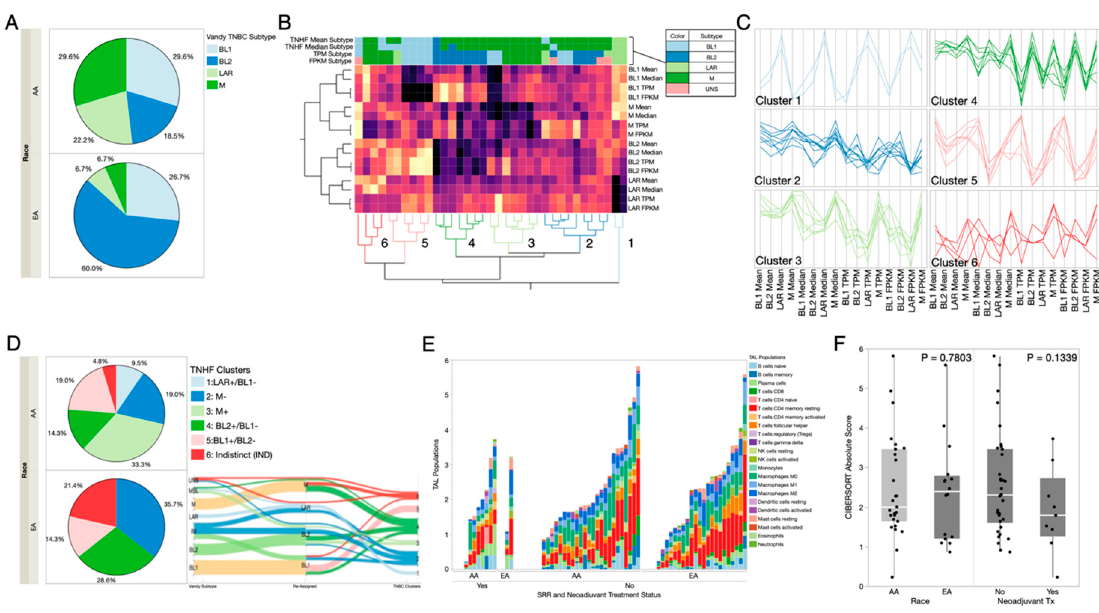
Figure 2. TNBC subtyping and distribution among SRR and treatment groups. ( A ) Distribution of re-assigned TNBC subtype calls across SRR race groups using the Vanderbilt calling method. ( B ) Clustergram heatmap of TNBCType call correlations for BL1, BL2, LAR, and M subtypes from use of the Vanderbilt tool with TPM (transcripts per million) and FPKM (fragments per kilobase of exon model per million reads mapped) values as input and our TNBC subtyping method (TNHF mean and median). Rows represent the di ff erent subtype correlations for the tools, and columns represent individuals. Using these correlations, our samples separate into six clusters, numbered at the bottom. Color map columns of the call reassignments removing IM and MSL are shown at the top of the heatmap (key to the upper right). Sample names are colored based on their cluster assignment. Reassignment of TNBC subtypes based on a dual-tool reduction method. Cluster Nodes: 1 = LAR +/ BL1 − , 2 = M − , 3 = M + , 4 = BL2 +/ BL1 − , 5 = BL1 +/ BL2 − , 6 = Indistinct (IND). ( C ) Parallel plots for each of the six clusters showing the correlation for the samples within the cluster to a given TNBC subtyping call / method (bottom). Cluster coloring matches that in panel 2B. ( D ) Sankey plot showing how samples reassign from the original TPM call, to the second most correlated call (for re-assignment of IM, MSL, and UNS samples) and their cluster assignment from panel B. ( E ) TNBC clusters (from panel B) and their distribution among SRR. ( F ) Total abundance of tumor-associated leukocytes estimated using CIBERSORT deconvolution methods is shown in comparison to SRR and treatment groups.